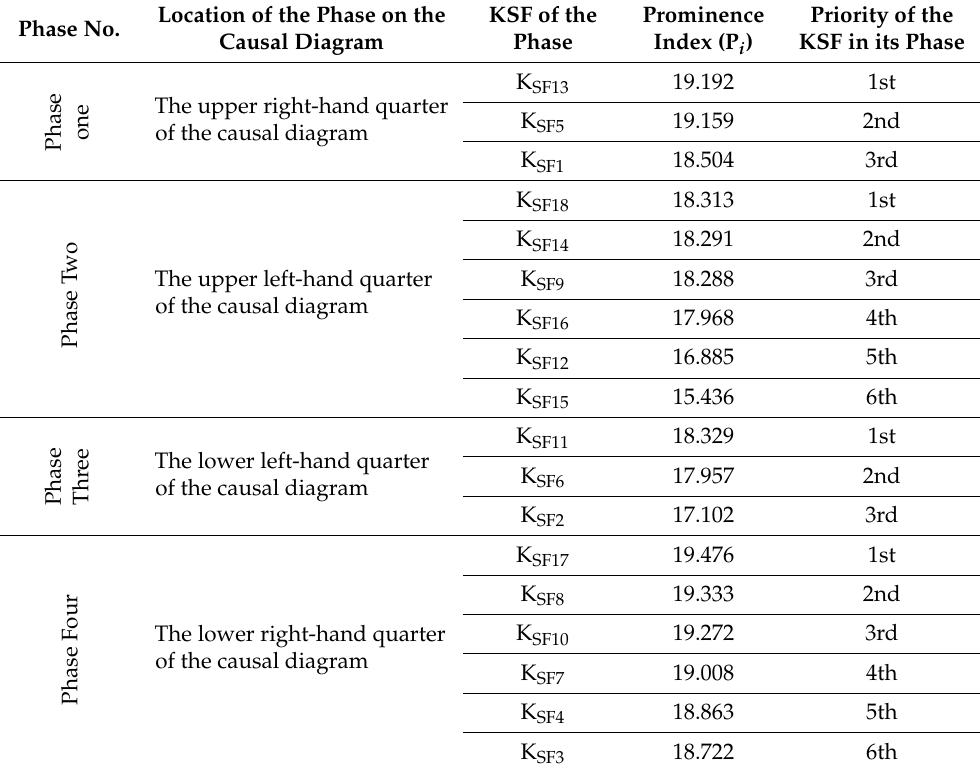
Table 5. Characteristics of the four phases of BIM implementation roadmap. Location of the Phase on Phase No.